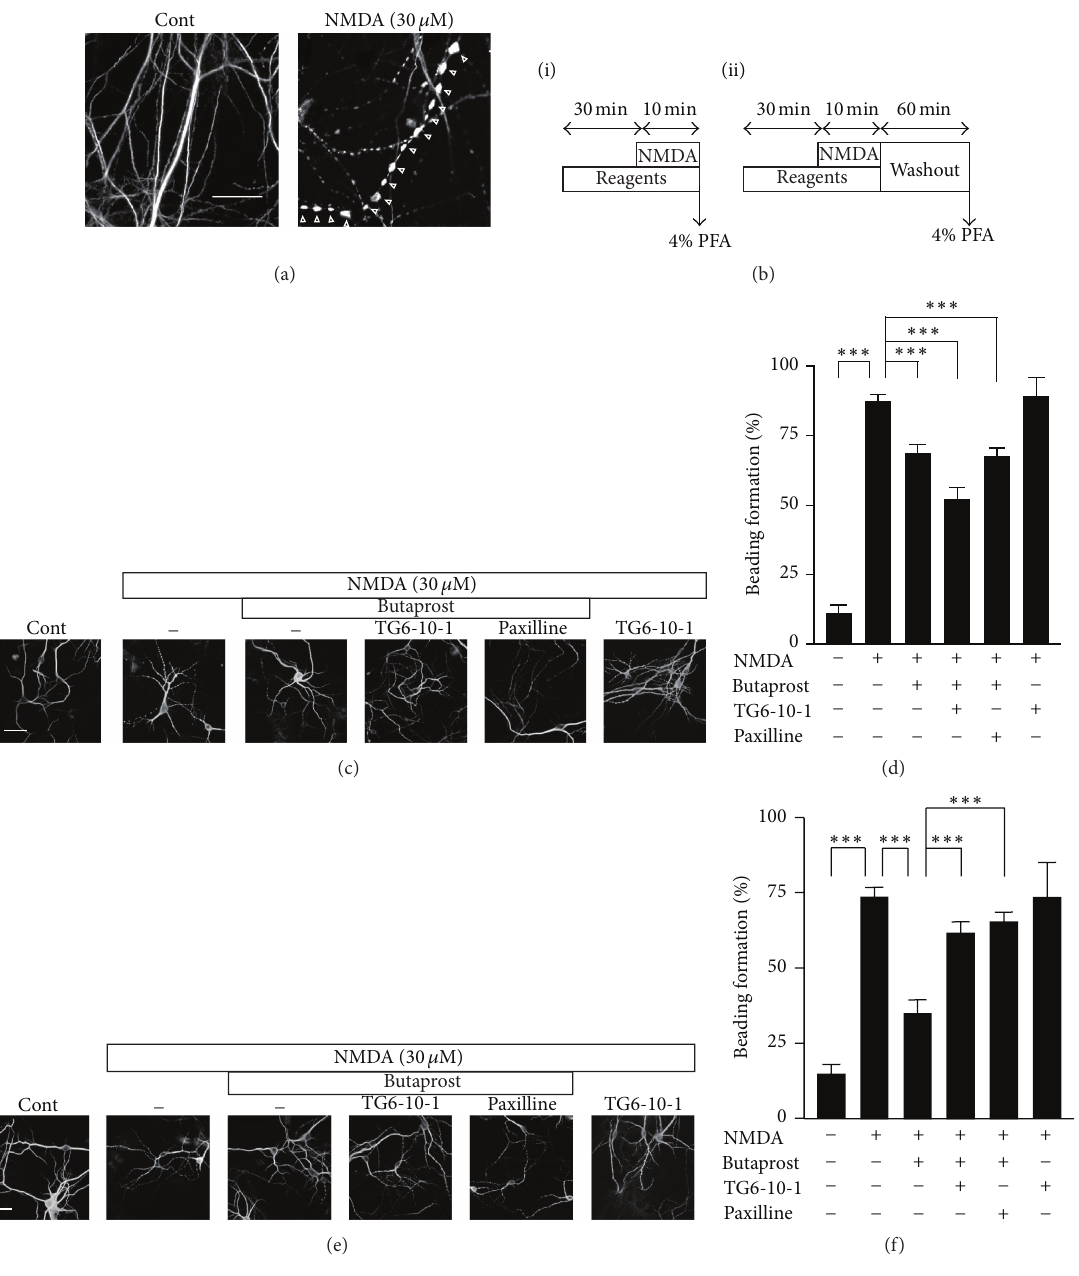
Figure 4: The facilitatory effects of butaprost, an EP2 receptor agonist, on the recovery phase of NMDA-induced dendritic beading through the activation of BK channels in the primary cultured mouse cortical neurons. (a) Immunofluorescent CLMS images for MAP2 in the primary culturedcorticalneuronsofpretreatment(leftpanel)orposttreatment(rightpanel)ofNMDA(30 𝜇 M)for10min.Arrowheadsindicatebeads- structure in the dendrite. Scale bar = 20 𝜇 m. (b) Cortical neurons were fixed 10min after the stimulation with NMDA (i) or 60min after the elimination of NMDA (ii). Experimental schedules of (i) and (ii) were corresponding to (c, d) and (e, f), respectively. Data are represented as themean ± SEM( 𝑛 =180–235 cells).(c,e)ImmunofluorescentCLMSimagesforMAP2intheprimaryculturedcorticalneuronsat10 minafter stimulation of NMDA (c) or 60 min after the elimination of NMDA (e). Butaprost (1 𝜇 M), TG6-10-1 (10 𝜇 M), an EP2 receptor antagonist, and paxilline (2 𝜇 M) were treated 30 min before the application of NMDA. (d, f) The formation of dendritic beading of 10min after the stimulation with NMDA (d) or 60 min after the elimination of NMDA (f). The columns and bars represent the mean ± SEM ( 𝑛 = 142–173 cells). Asterisks indicate a significant difference between the values ( ∗∗∗ 𝑃 < 0.001 , one-way ANOVA post hoc Tukey’